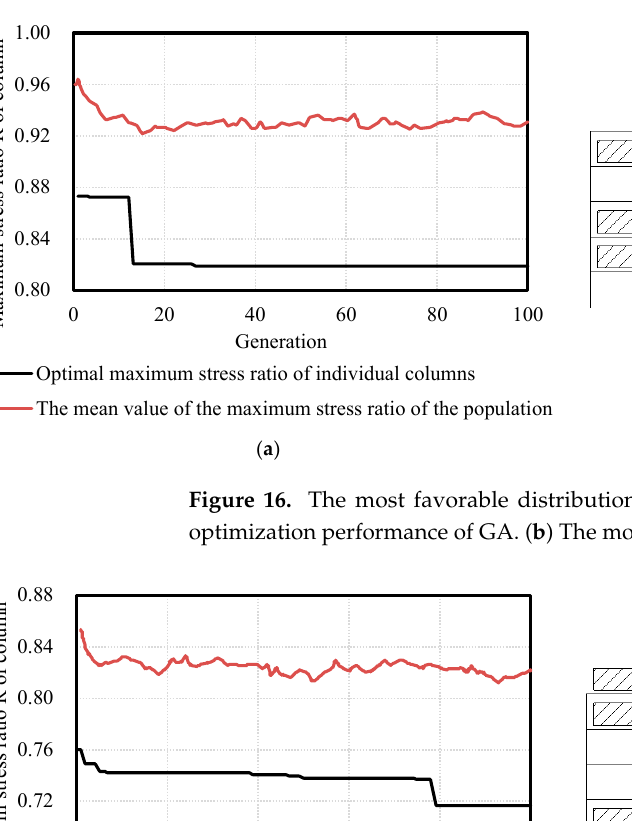
Figure 15. The most favorable distribution of load under 80% full load. ( a ) Tracking chart of optimization performance of GA. ( b ) The most favorable distribution of load (H = 2.68, P = 0.07).